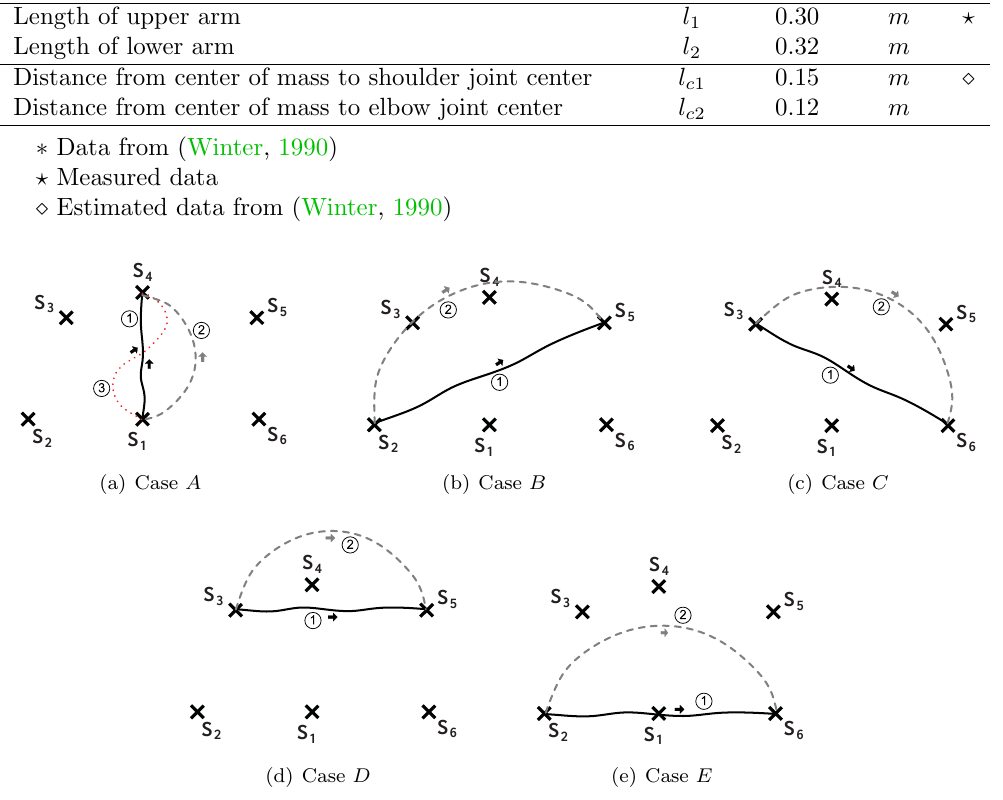
Figure 4: Five cases of human arm